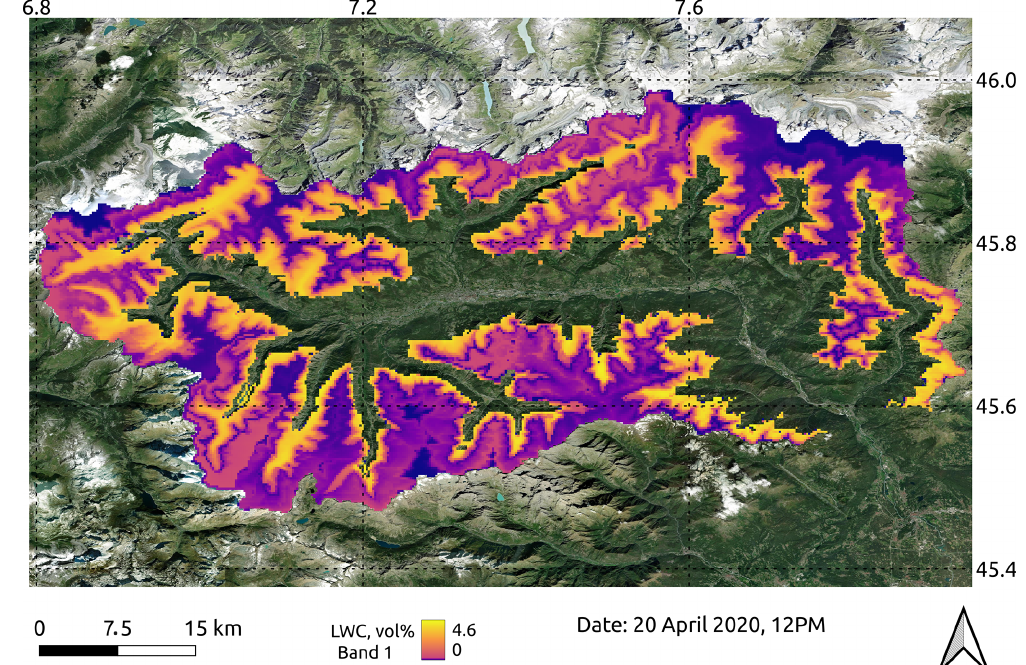
Figure 8. Map of bulk volumetric liquid-water content for the Aosta Valley (LWC, same as θ W ), 20 April 2020 at 12:00. The background layer is from the ESRI satellite